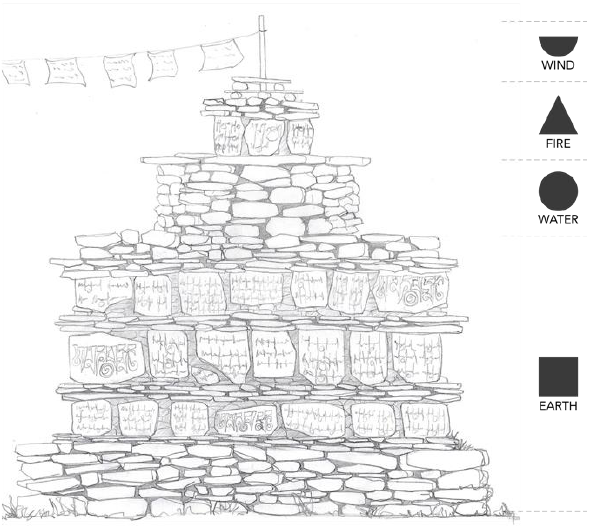
Figure 15. Front view of stone chorten (Authors).